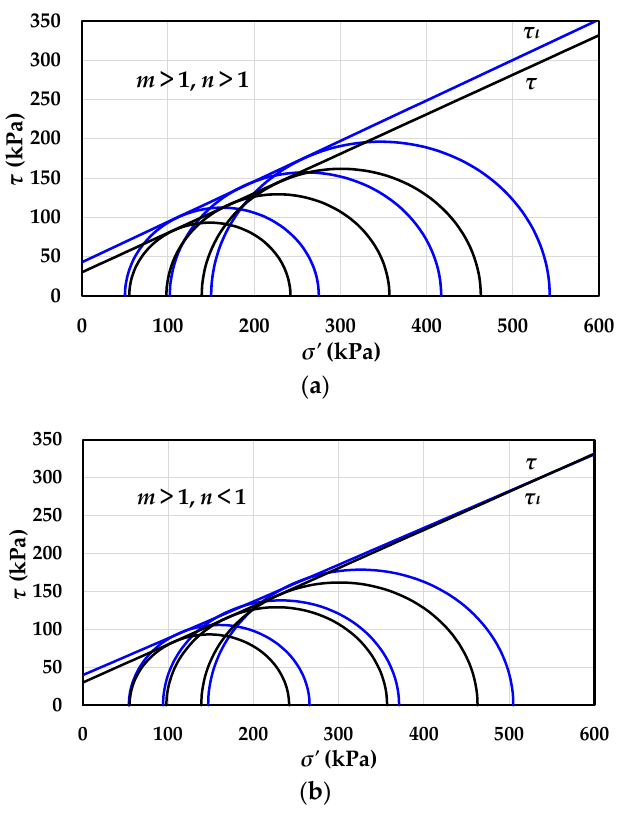
Figure 6. Shear strength envelope diagrams for unreinforced soil and root-soil composites: ( a ) m = 1.426, n = 1.002, ( b ) m = 1.326, n = 0.978.